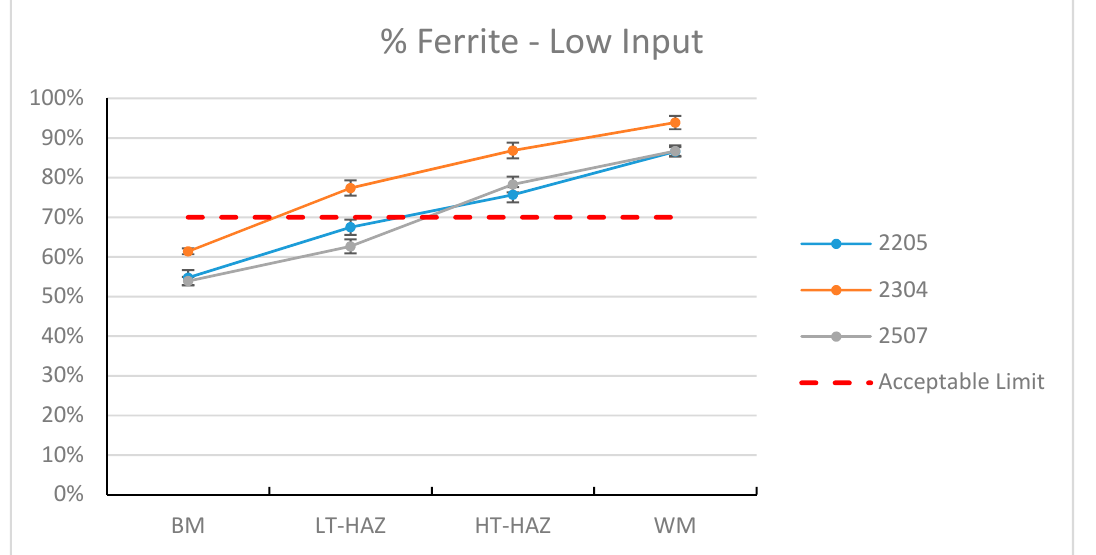
Figure 9. Volumetric Fraction of ferrite—Low Input: BM; LT-HAZ; HT-HAZ; WM.